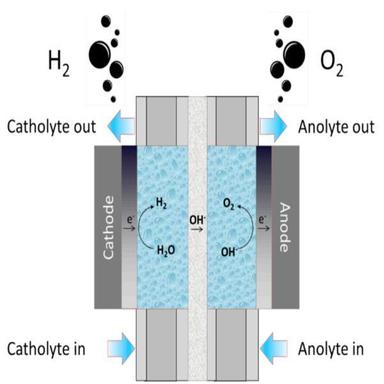
Cell potential as a function of current density, showing the different contributions to the potential. The secondary y-axis depicts the energy consumption per Nm3 of hydrogen, based on a typical faradaic efficiency of 98 % . No values are indicated on the x-axis, due to the significant differences between alkaline electrolyzers: traditional alkaline electrolyzers achieved cell potentials of 1.8–1.9 V at 0.15 A cm− 2 , but some modern electrolyzers can achieve the same potentials at >